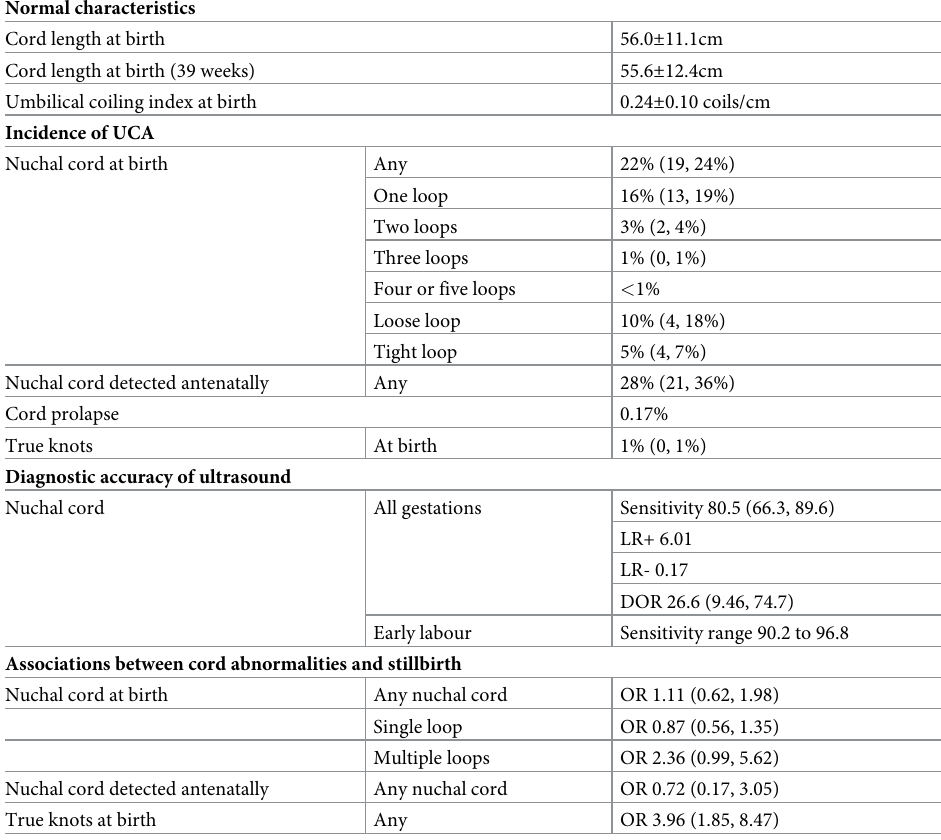
Cord prolapse and adverse outcomes . We were unable to perform meta-analysis to investi- gate the relationship between cord prolapse and any of our outcomes of interest due to a lack of available data. A summary of normal cord characteristics, UCA incidences, diagnostic accuracy data, and associations between UCA and stillbirth is provided in Table 5. Table 5. Summary of